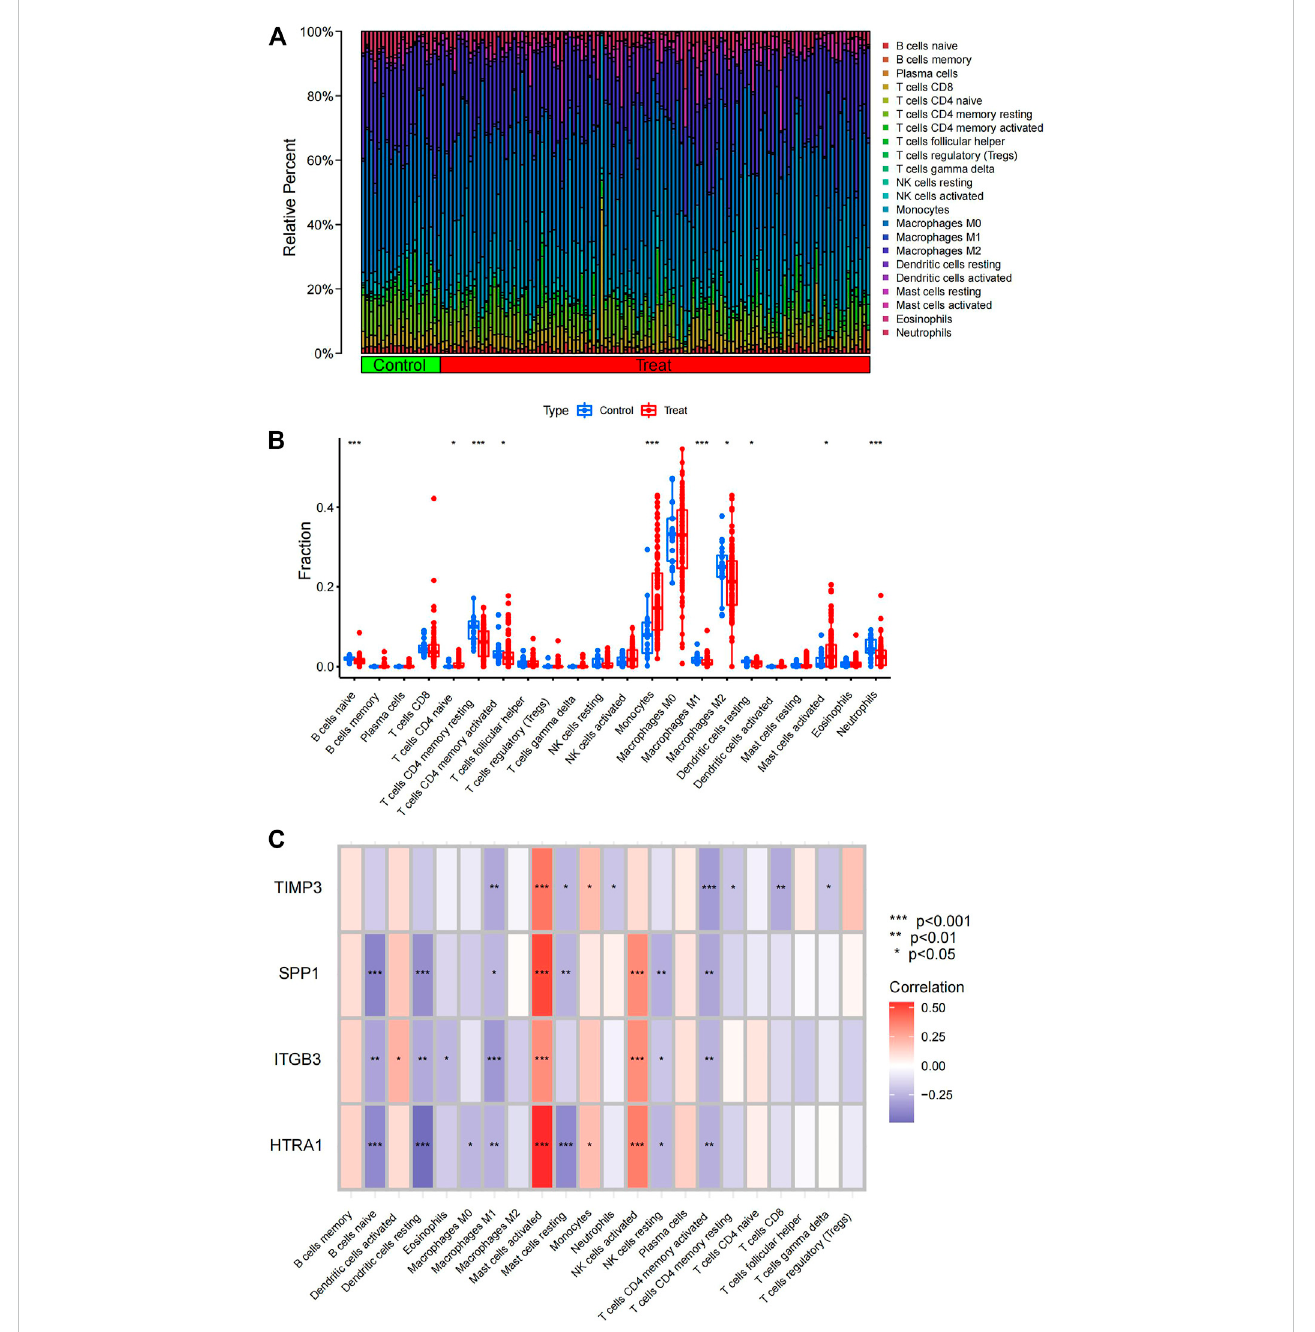
FIGURE 3 Analysis of immune cell type in fi ltration. (A) Relative abundance of immune cell types in the IPF and control samples. (B) Differences in immune cell in fi ltration between IPF and control samples. (C) EMT-related DEGs displayed based on an immune correlation analysis. IPF, idiopathic pulmonary fi brosis; EMT, epithelial – mesenchymal transition; DEGs, differentially expressed